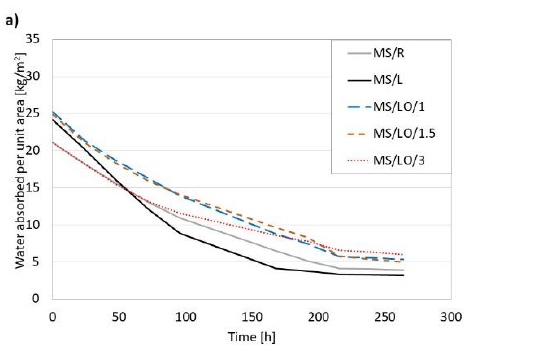
Figure 5. Mšené specimens at the end of the drying test after saturation with 1 wt.% of NaCl in respect to the specimens’ weight: ( a ) MS/R; ( b ) MS/L; ( c ) MS/LO-1; ( d ) MS/LO-1.5; ( e ) MS/LO-3; ( f ) MS/LO-3 after removing the salt efflorescence.